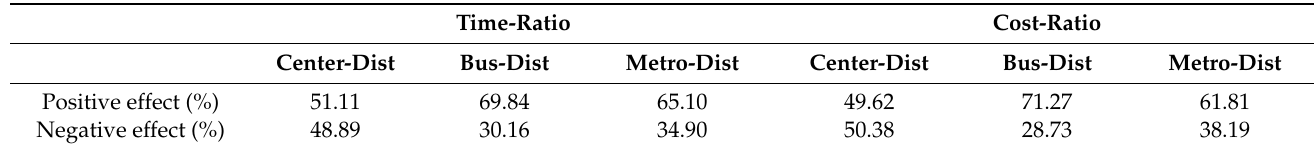
Table 4. The percentage of positive and negative effects of each explanatory variable.